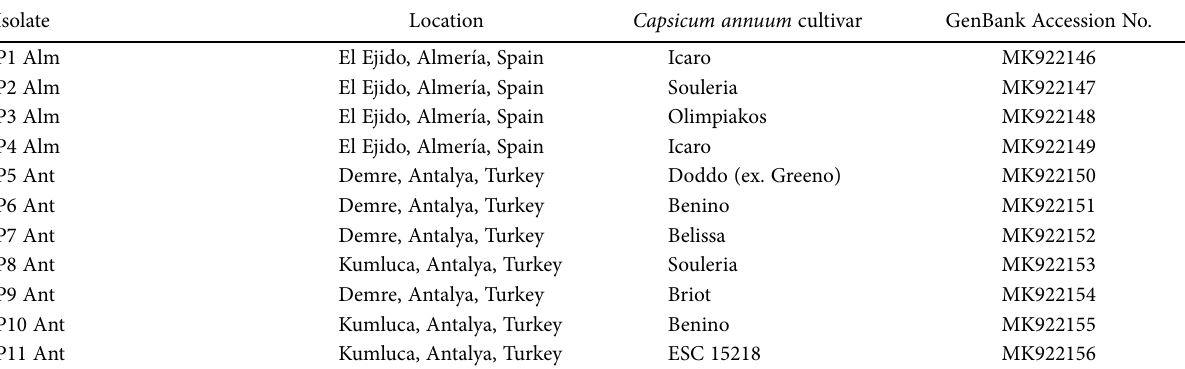
Table 1. Tomato spotted wilt virus isolates collected from pepper and characterised in this study. Isolate name, and origin location, host pep- per cultivar, and GenBank accession numbers are